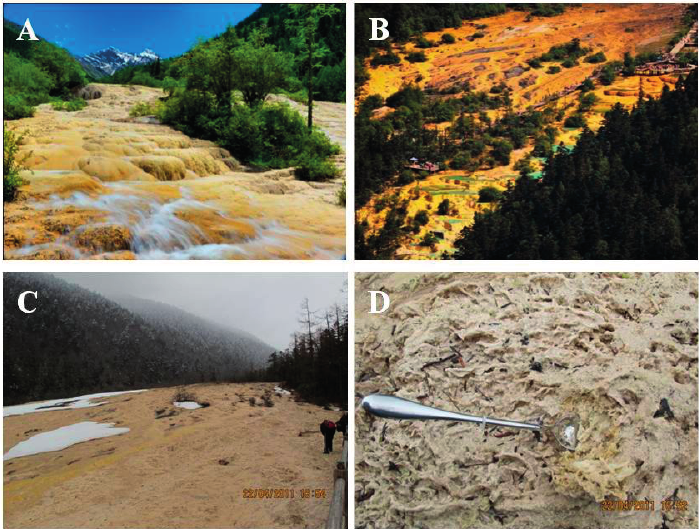
Figure 1. Photographs of the famous Jinshapudi sloping shoal. Panel ( A ) in July; ( B ) in September. Panel ( C ), in April. Panel ( D ), travertine samples collecting sites as shown in